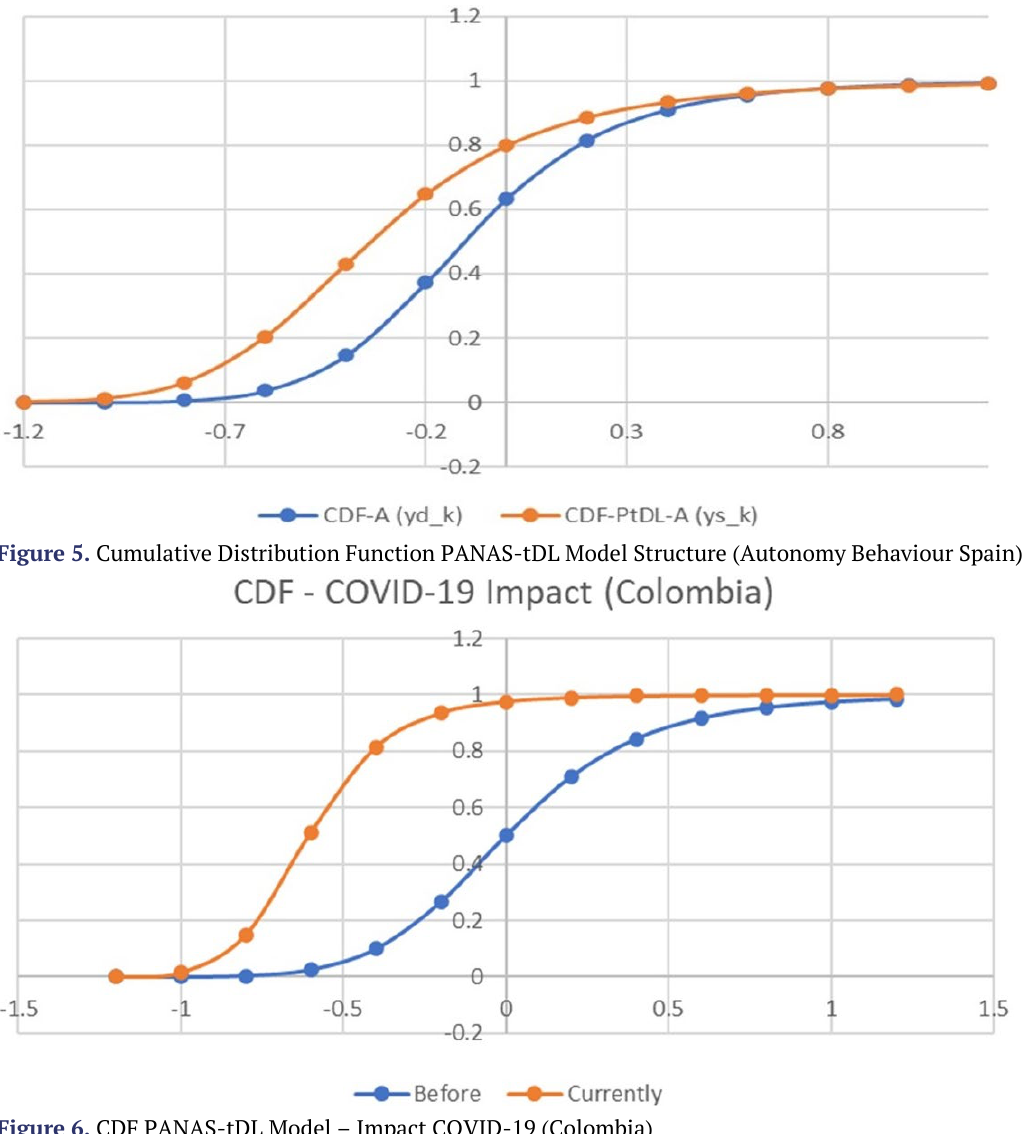
Figure 6. CDF PANAS-tDL Model – Impact COVID-19 (Colombia)